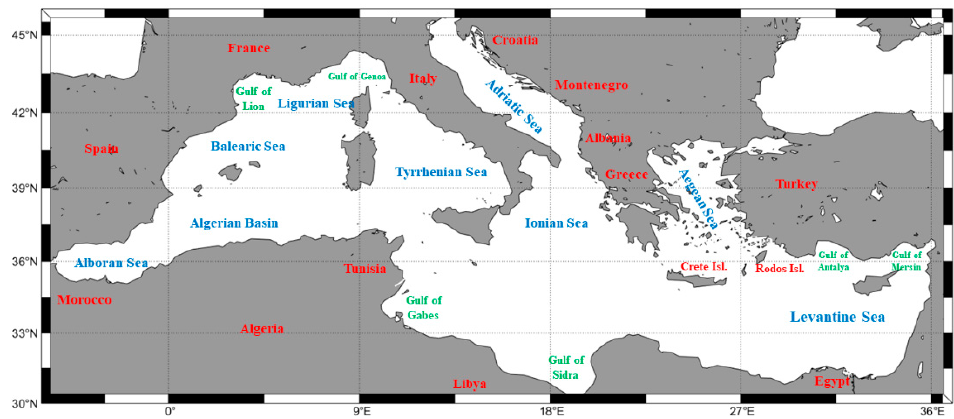
Figure 1. Mediterranean areas that are mentioned in the text.